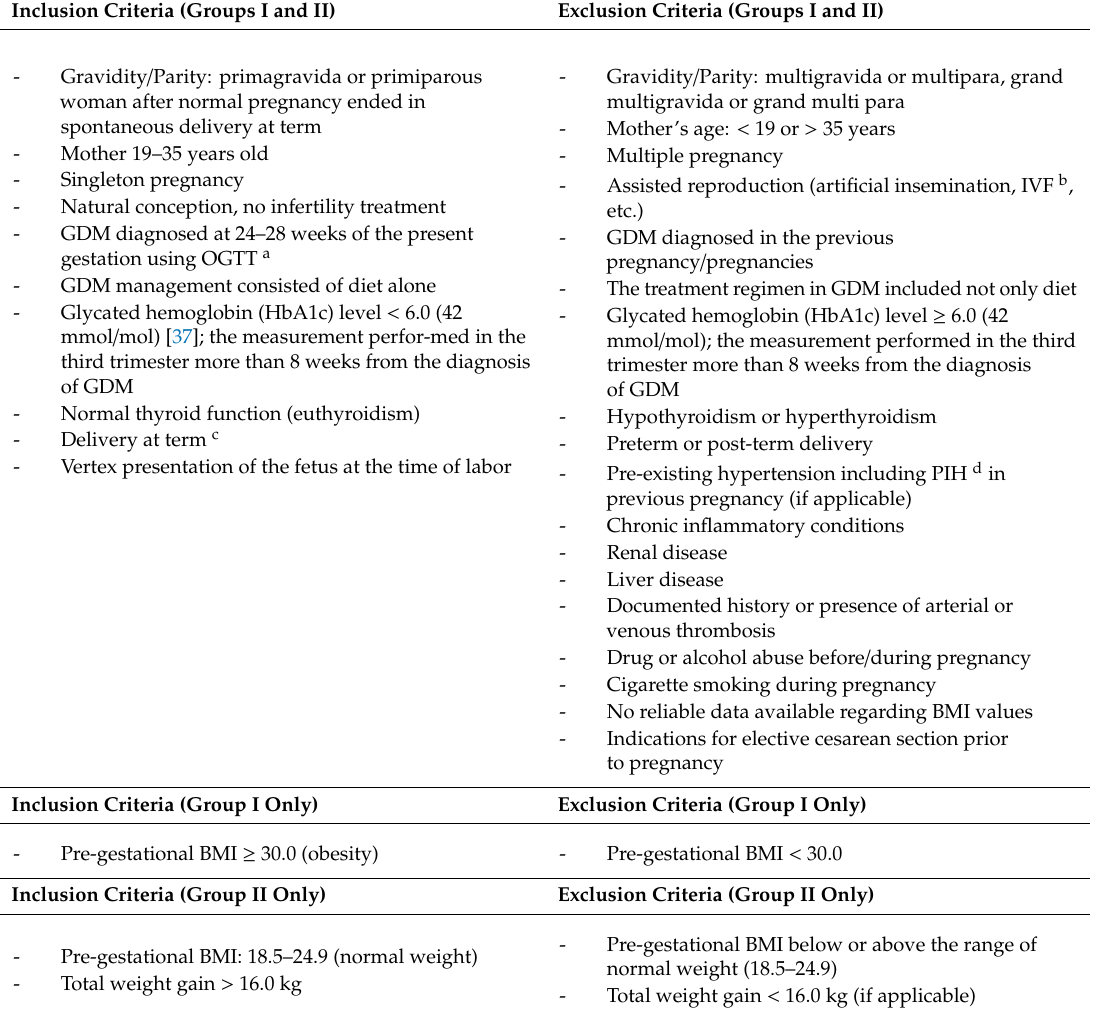
Table 2. Inclusion and exclusion criteria for the respectively studied groups: pre-gestational maternal obesity (PGMO; group I) and excessive gestational weight gain (EGWG; group